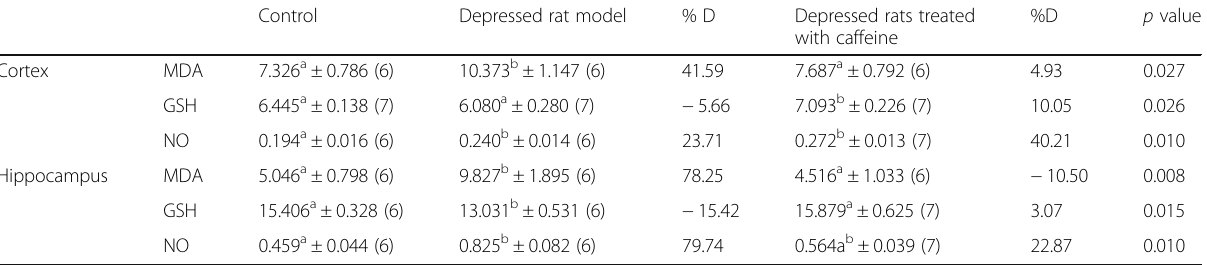
Table 3 Effect of daily caffeine treatment (30 mg/kg) on the levels of lipid peroxidation (MDA) (nmol/g), reduced glutathione (GSH) (mmol/g), and nitric oxide (NO) ( μ mol/g) in the cortex and hippocampus of rat model of depression induced by reserpine